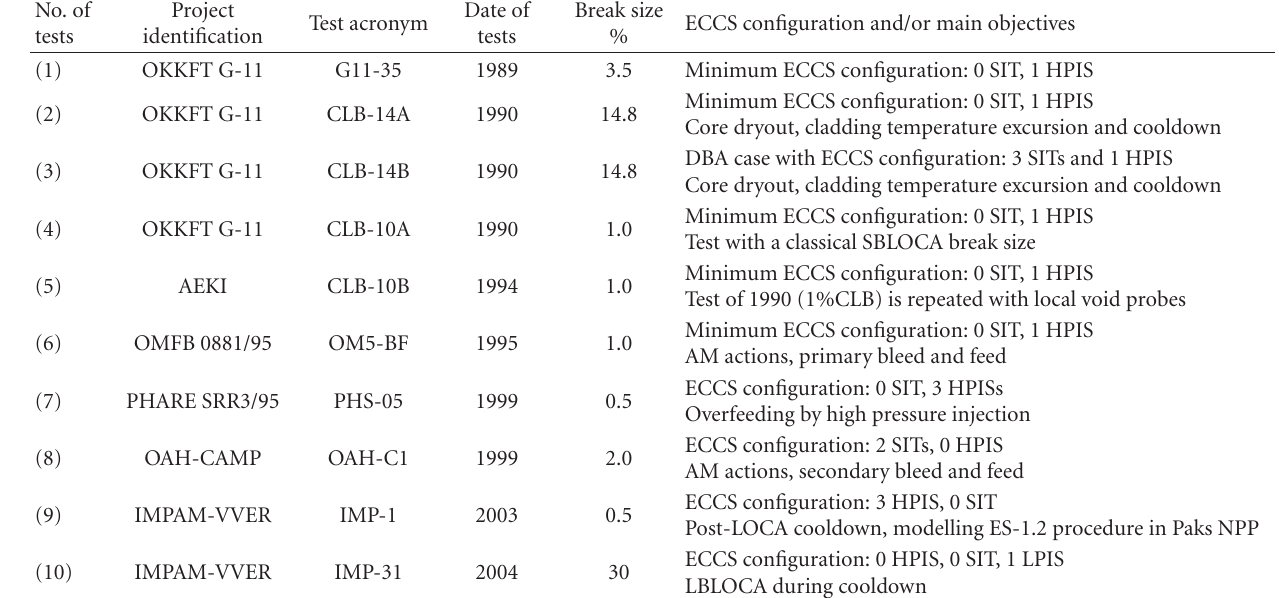
Table 2: Cold leg breaks of di ff erent